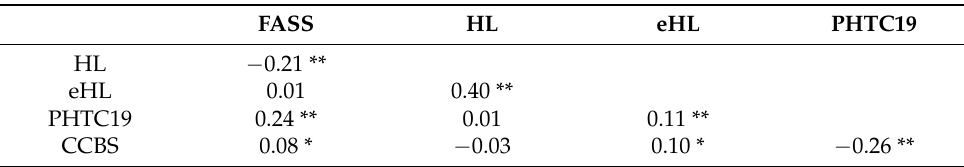
Table 2. Correlation matrix for selected measures analysed in regression models (Spearman ρ coefficients).